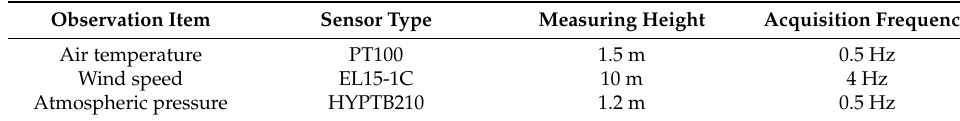
Table 1. Meteorological observation at TZ and